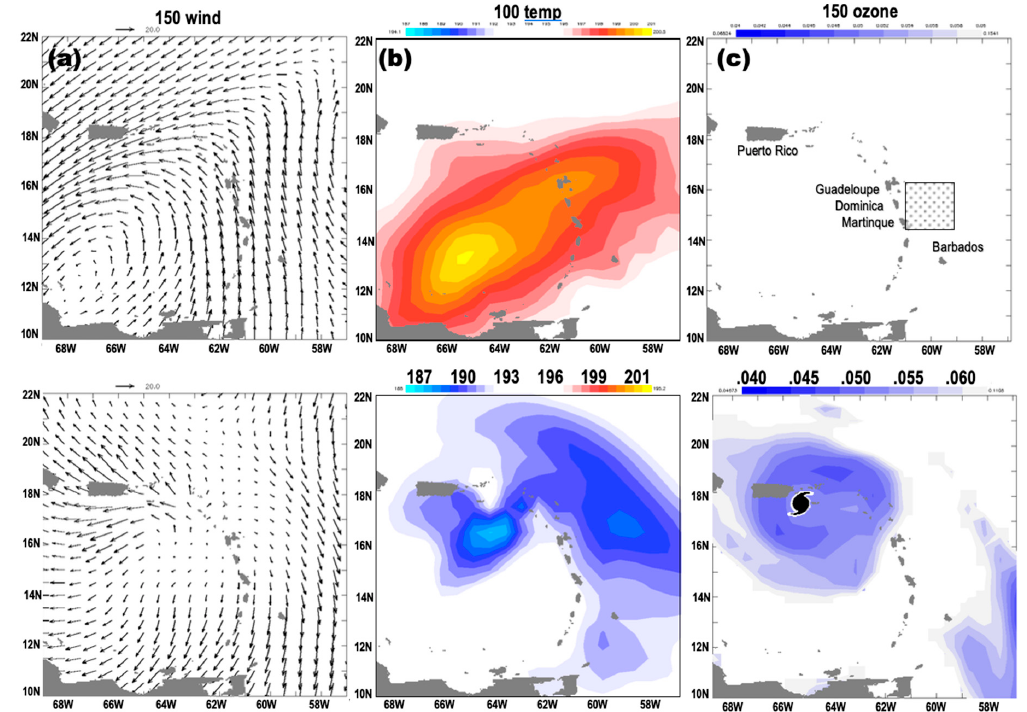
Figure 5. Maps of ( a ) 150 hPa winds, ( b ) 100 hPa temperature, and ( c ) 150 hPa ozone mixing ratio (shaded < 0.06 ppm), (upper) 0Z 17 September and (lower) 00Z 20 September 2017. Island labels and Maria intensification area shown by box in ( c ) upper. CFSr2 time series appear in the Appendix A.